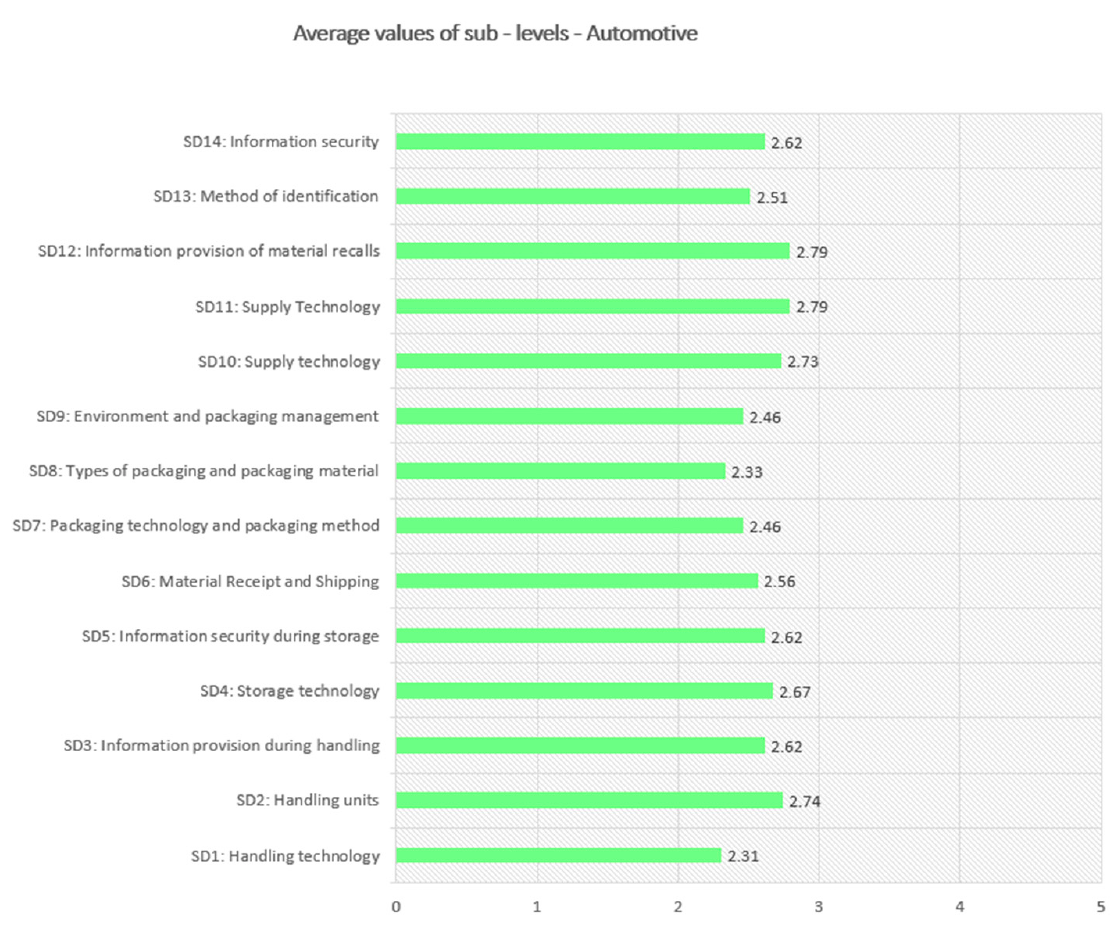
Figure 7. Average values in the automotive sector.